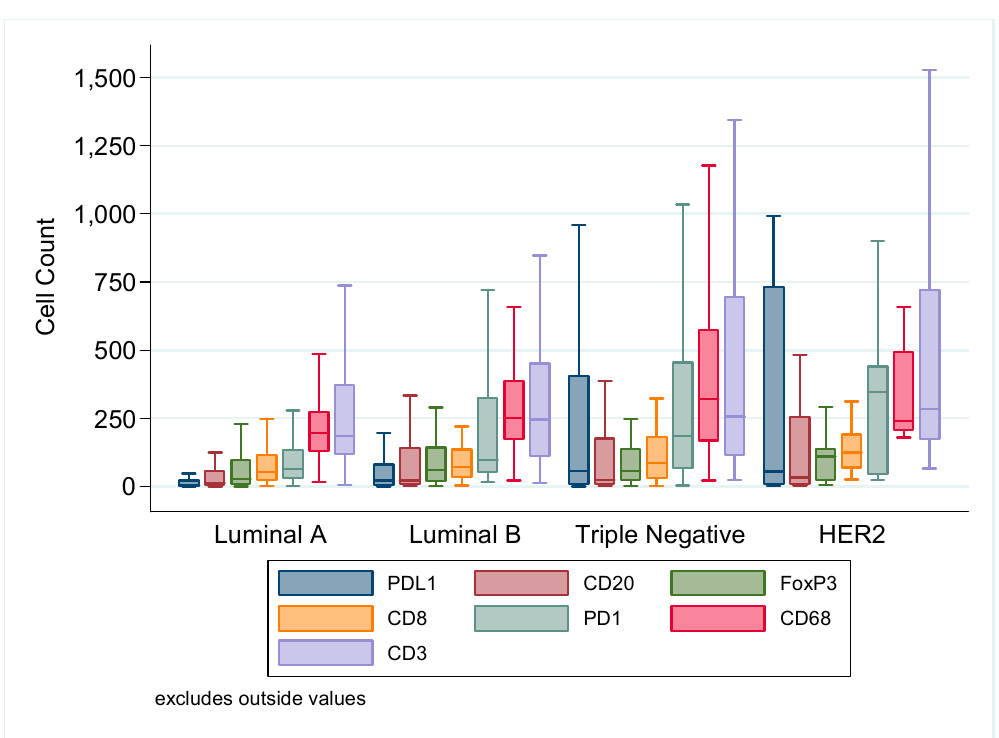
Figure 3. Immune cell counts according to intrinsic subtype of breast cancer. There is a significant difference in expression for all markers across each subtype (CD3, p = 0.026; CD8, p = 0.017; CD20, p = 0.006; CD68, p < 0.001; PD-1, p < 0.001; PD-L1, p < 0.001; Kruskall–Wallis test).